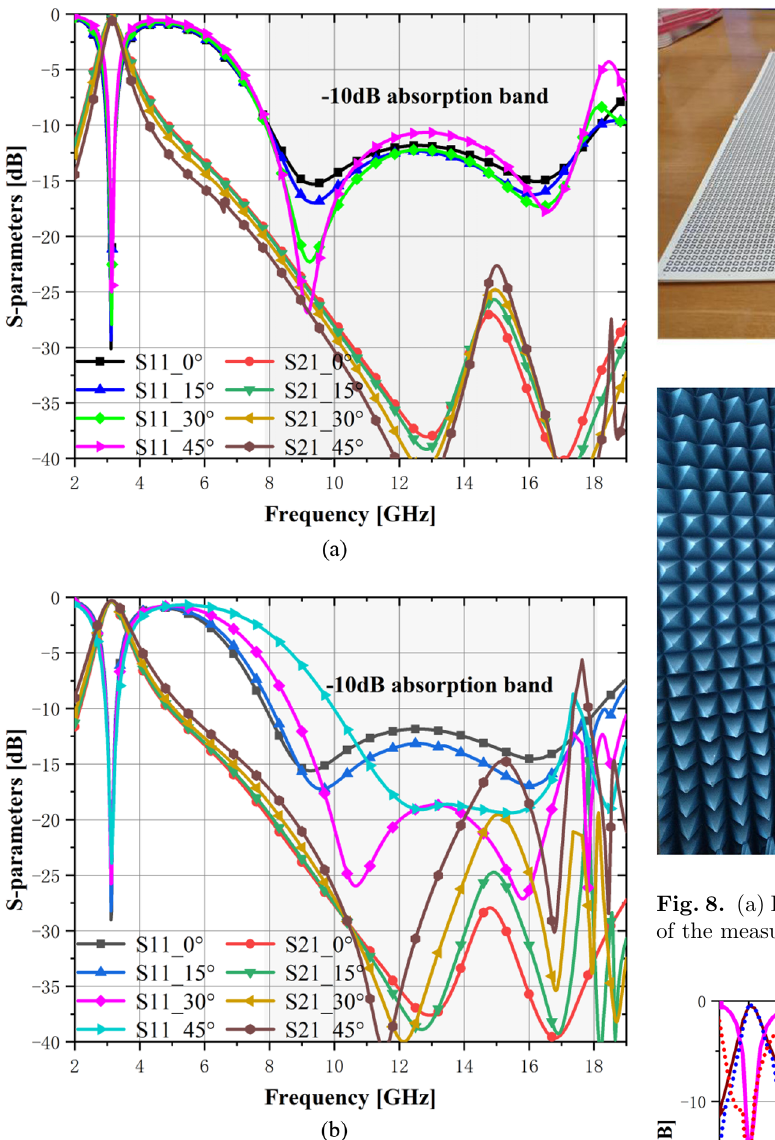
Fig. 7. S-parameter of the designed FSR for different incident angles under (a) TE polarization, (b) TM polarization.